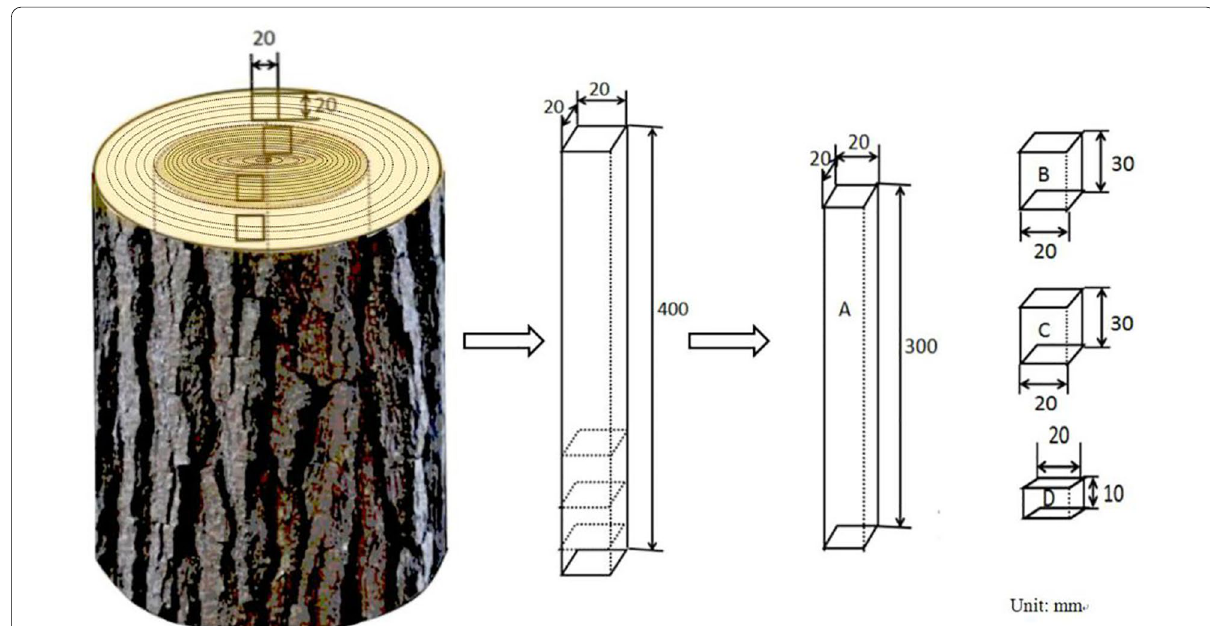
Fig. 1 Preparation of Pinus radiata samples. ( A MOR and MOE. B Compressive strength parallel to the grain. C MFA, crystallite size, relative crystallinity. D Anatomical samples and chemical